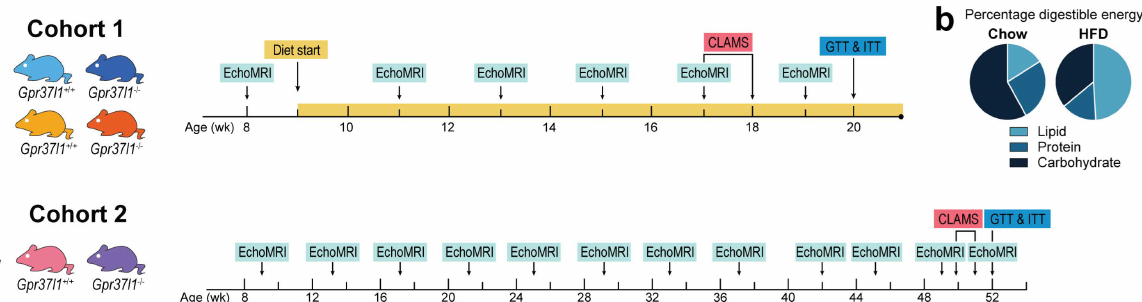
Figure 1. Schematic indicating timeline of experimental interventions. Gpr37l1 − / − and wildtype littermate control ( Gpr37l1 +/+ ) mice were allocated to 2 cohorts. ( a ) Cohort 1 mice were fed either high-fat diet (HFD) or standard chow for 12 weeks, beginning at 9 weeks of age ( n = 10 for all groups). Body composition was measured regularly by an NMR–MRI method (EchoMRI). Mice were subjected to respirometry using the Comprehensive Lab Animal Monitoring System (CLAMS) and underwent a glucose tolerance test (GTT) and an insulin tolerance test (ITT) at the ages indicated. ( b ) Macronutrient composition of chow and HFD diets, expressed as the percentage of digestible energy in the diet. ( c ) Cohort 2 was maintained on standard chow until 1 year of age ( n = 20 for both groups). During this time, body composition was measured using EchoMRI, and GTTs and ITTs were performed at the ages indicated. A subset of cohort 2 mice underwent CLAMS ( n = 10 Gpr37l1 +/+ and Gpr37l1 − / −